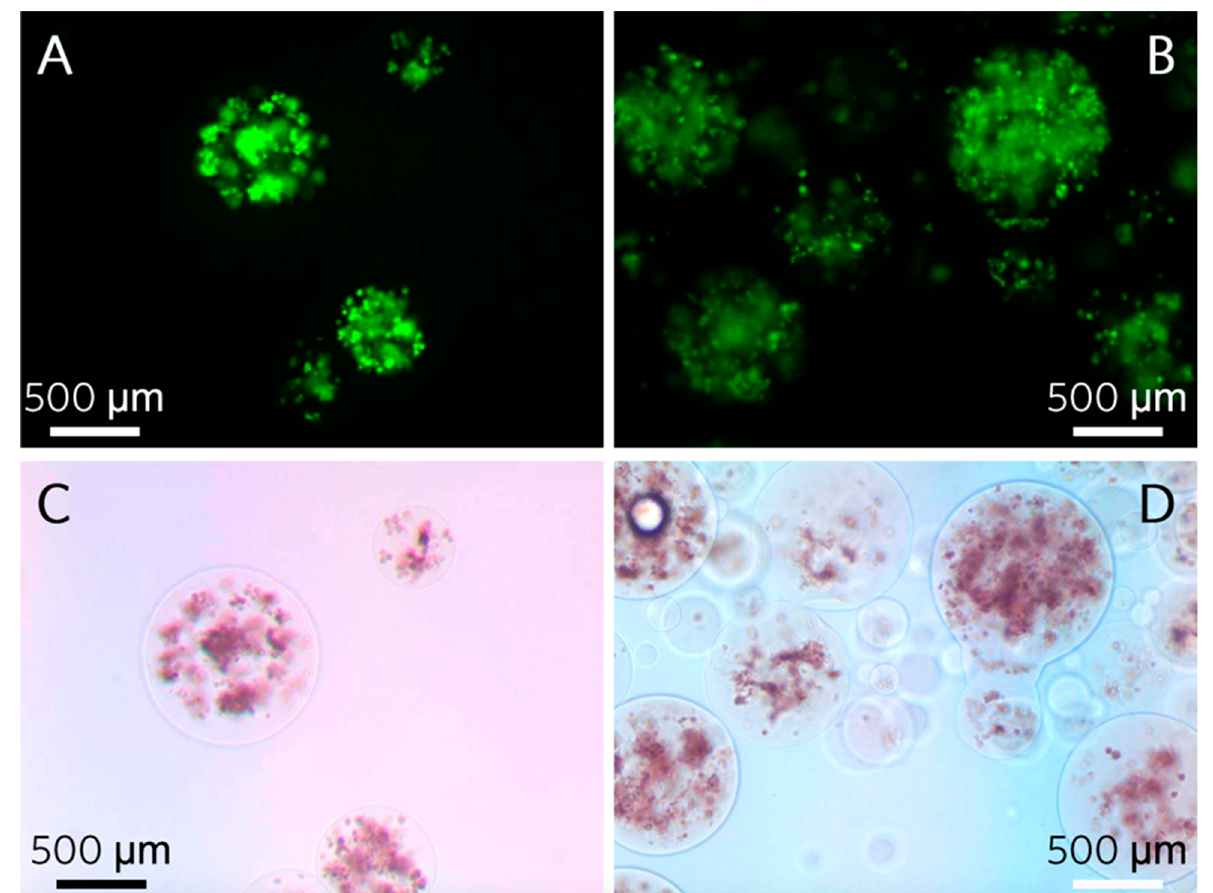
Figure 5. Two weeks post microencapsulation in basal maintenance ( A , C ) or osteogenic differentiation ( B , D ) media. Microencapsulated hTERT-hMSCs show fluorescent labeling of calcium in hydroxyapatite ( A , B ) and when identical microspheres were stained with Alizarin Red S, there was no red stain. There was no observable difference between microspheres receiving basal or osteogenic media.